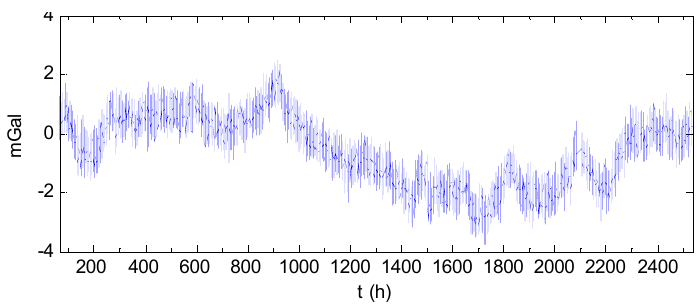
Figure 12. Result after the drift was compensated using a cubic curve (after subtracting the starting value).